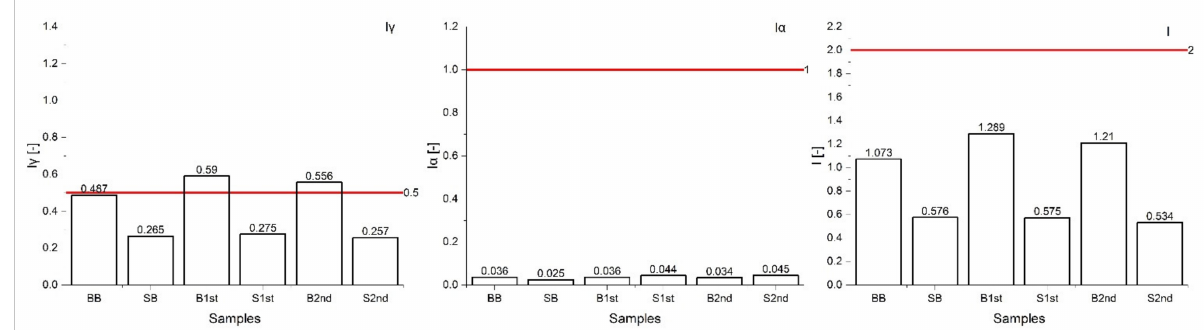
Figure 9. Comparison of the level indices I γ , I α , and AUI with the limit values (represented by red lines).